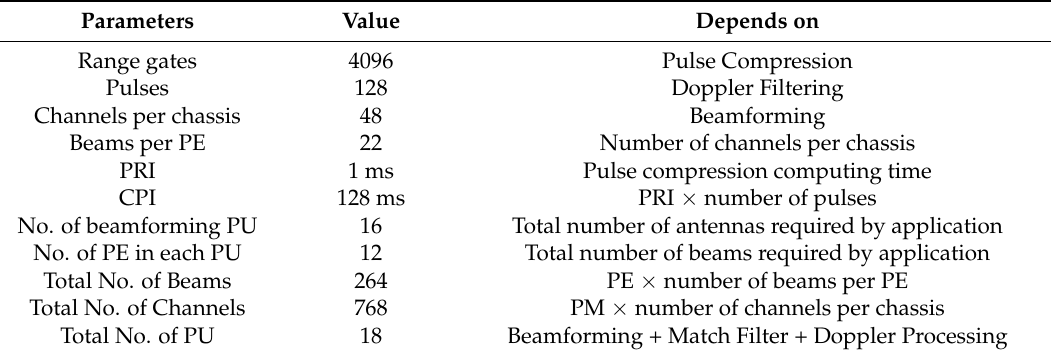
Table 5. Example digital array radar system